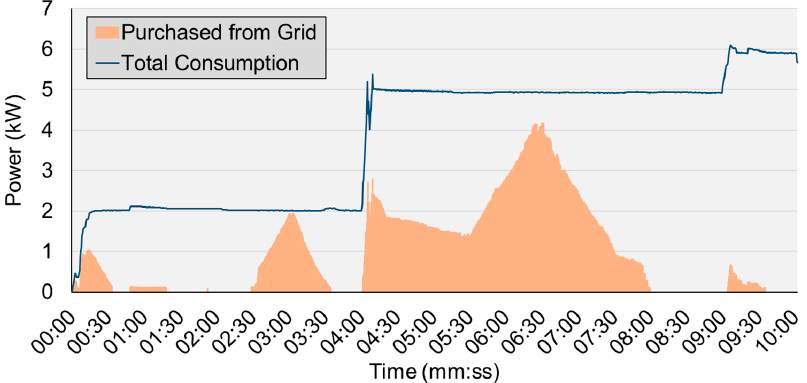
Figure 14. Power purchased from the utility grid in comparison to total consumption during the laboratory experiment.